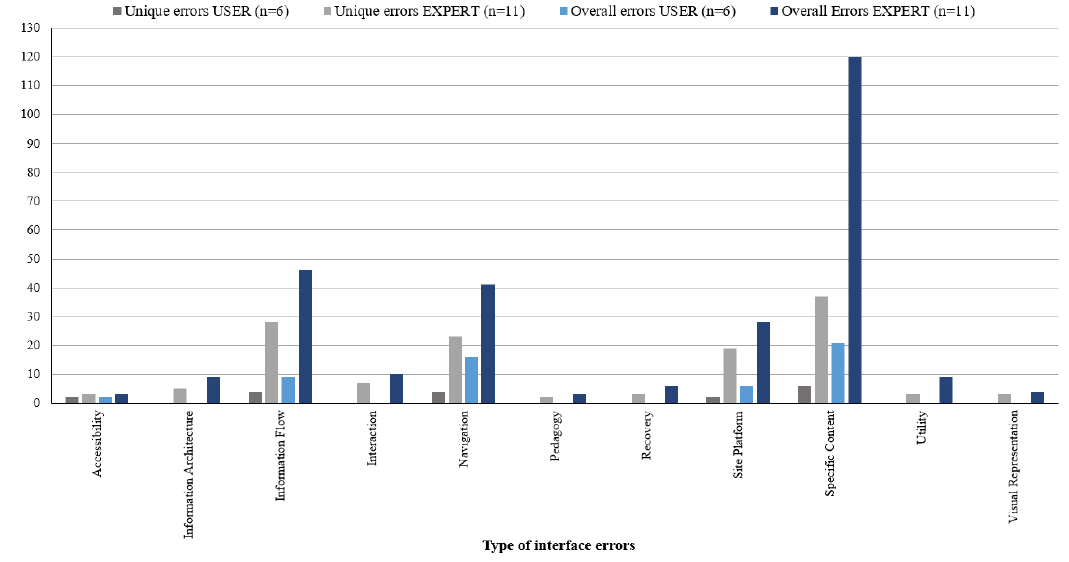
Figure 4. Frequency of overall and unique errors identified by carers (USER) and EXPERT (HCP and LD) evaluator groups.